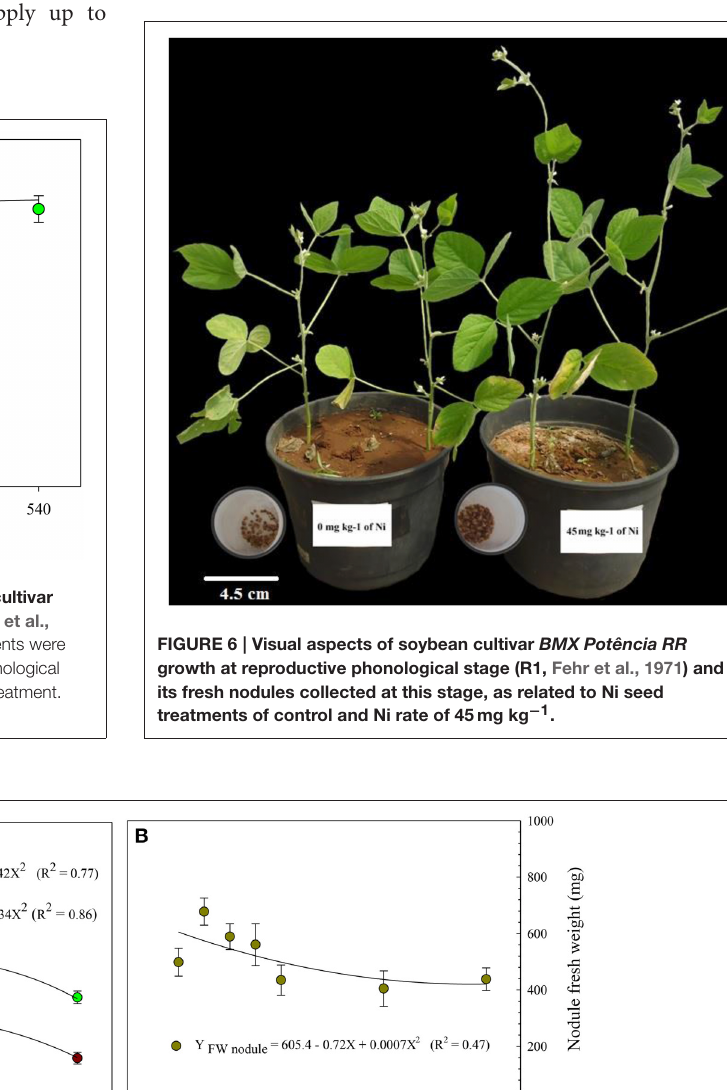
Frontiers in Environmental Science |